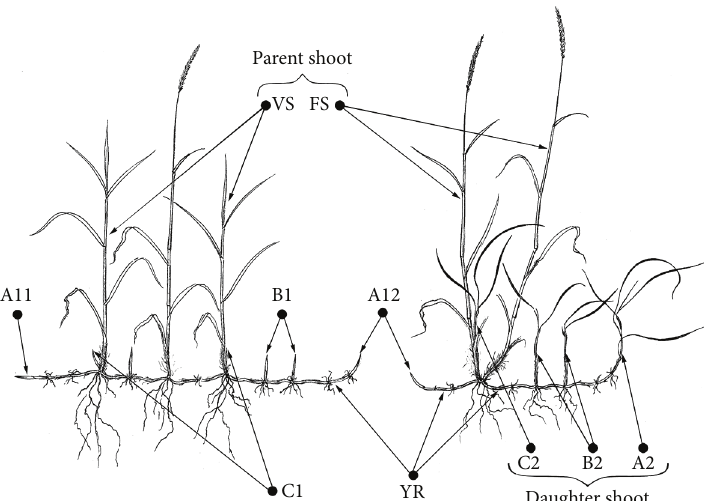
Figure 1: General morphology of Leymus chinensis. Abbreviations: A11, horizontal apical rhizome bud; A12, vertical apical rhizome bud; A2, daughter apical rhizome shoot; B1, axillary rhizome bud; B2, daughter axillary rhizome shoot; C1, shoot bud; C2, daughter axillary shoot; FS, parent flowering shoot; VS, parent vegetative shoot; YR, young rhizome [25]. Here we considered A11, A12, A2, B1, and B2 as the daughter shoots from rhizomes (DSR), C1 and C2 as the daughter shoots from tillers (DST); all these young shoots are included in the total number of daughter shoots (TDN), and YR as rhizome number